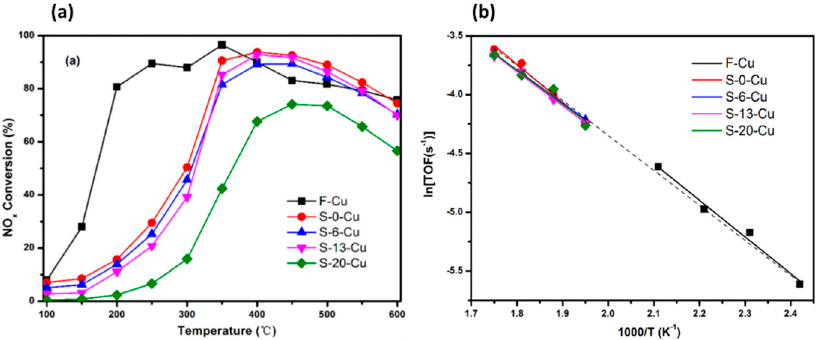
Figure 5. ( a ) NOx conversion of fresh and sulfated samples over Cu-SSZ-13; gas composition: 500 ppm NO, 500 ppm NH 3 , 5% O 2 , 7% CO 2 , N 2 . Adapted with permission from Ref. [30]. Copyright 2017 Applied Catalysis B: Environmental. ( b ) TOFs results over fresh and sulfated catalysts.